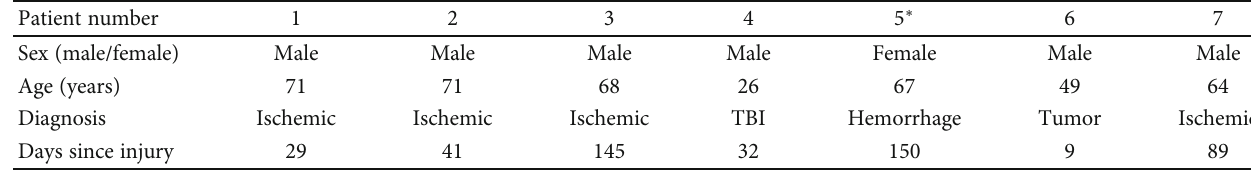
Table 3: Characteristics of the patients included in interview.